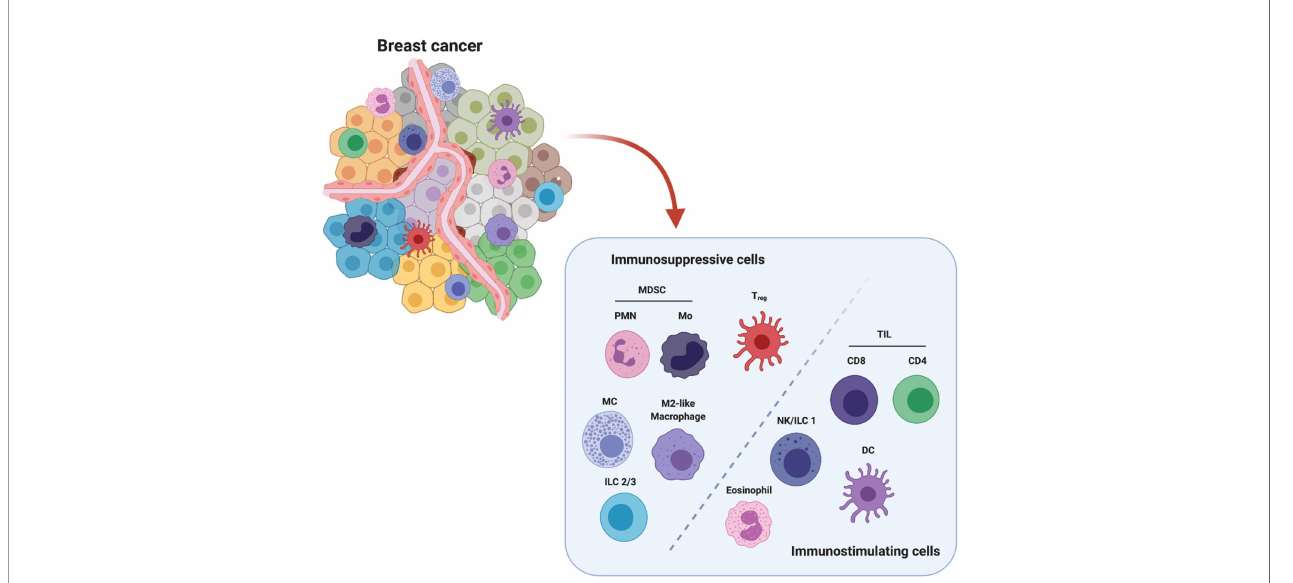
FIGURE 1 | Breast cancer microenvironment is populated by diverse in fi ltrating immune cells. These immune cells are categorized into immunosuppressive population and immunostimulating population (e.g.) according to their major characteristics in modulating breast cancer. The immunosuppressive cells include polymorphonuclear myeloid-derived suppressor cells (PMN-MDSCs), monocytic MDSC (Mo-MDSC), regulatory T cells (Treg), mast cells (MC), M2-like macrophages and type 2/3 innate lymphoid cells (ILC 2/3). The immunostimulating cells include tumor in fi ltrating lymphocytes CD8 + and CD4 + T cells, nature killer cells/type 1 innate lymphoid cells (NK/ILC1), dendritic cells (DCs) and